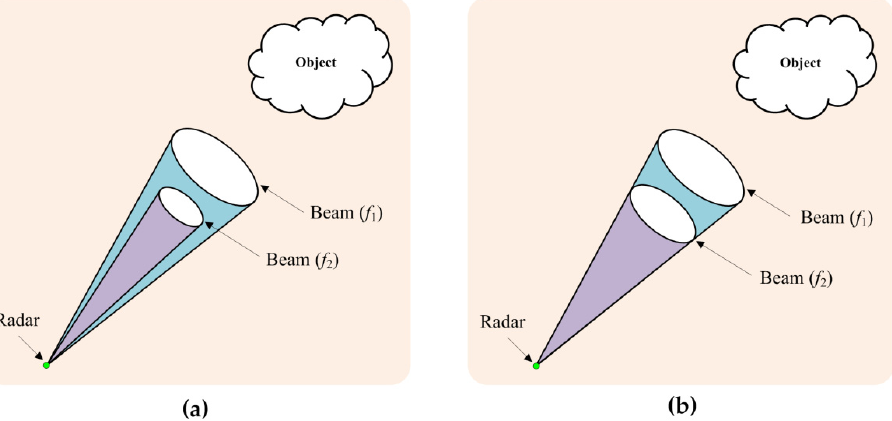
Figure 1. Dual-band radar emitting two independent beams: ( a ) Unequal beamwidth in two fre- quency bands; ( b ) Equal beamwdith in two frequency bands. Atmospheric particles, such as clouds, snow, and rain, are the typical detected objects.